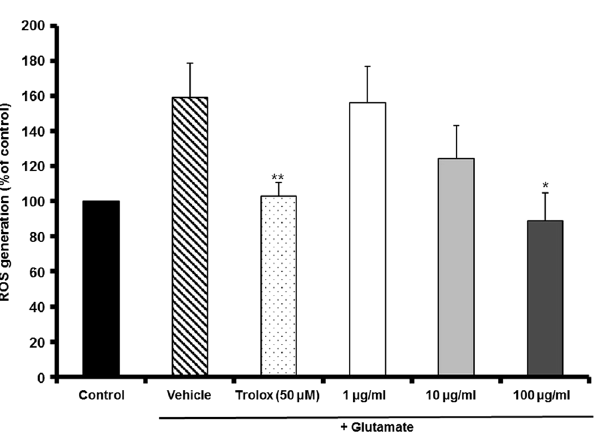
Figure 2. The effect of MF extract on glutamate-induced ROS generation in HT22 cells. Results are expressed as percentages of the values of control cells. * p < 0.05 and ** p < 0.01 vs. glutamate-treated